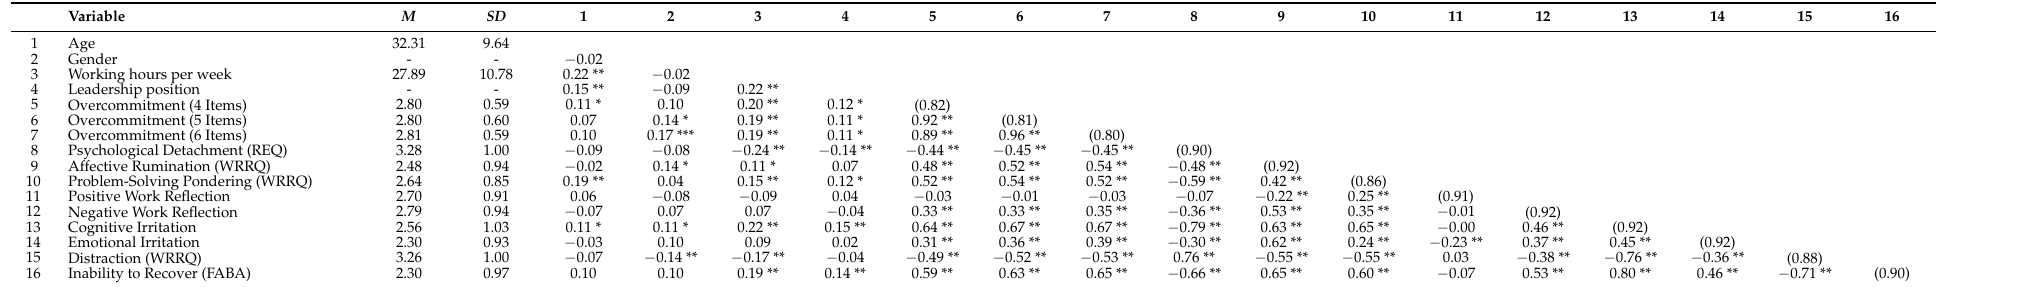
Table 1. Means, Standard Deviations, and Zero-Order Correlations among Study Variables (Sample